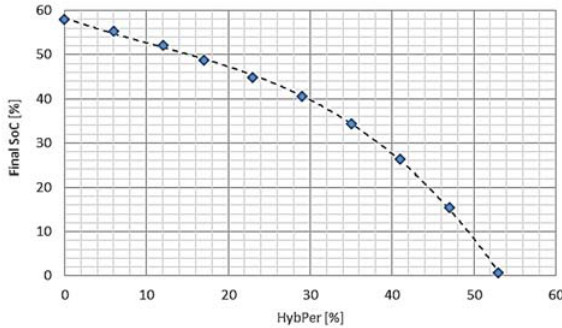
Figure 8. Global state of change ( SoC ) (batteries and EDLCs) for topology 2 as a function of the hybridization percentage at the end of the ARTEMIS cycle.